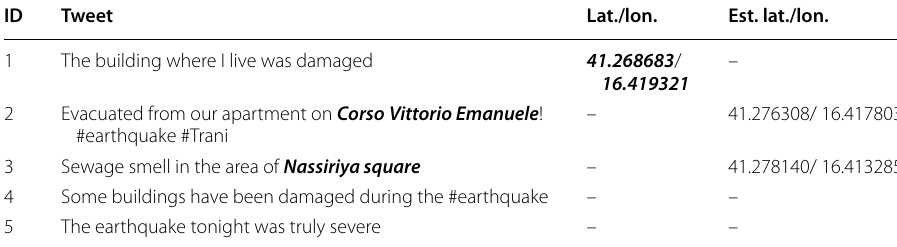
Table 5 Example of generated